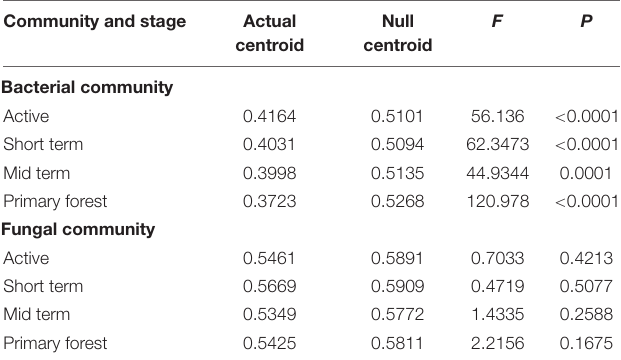
TABLE 1 | Significance test for centroid differences between observed communities in each successional stage and the null model simulations based on Bray-Curtis